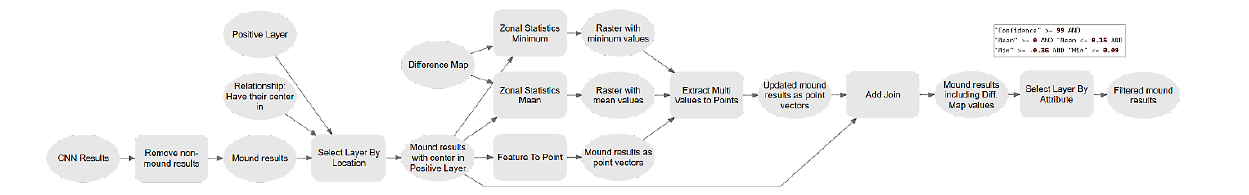
Figure 8. Post classification including non-mound removal as well as location-based and attribute- based filtering.